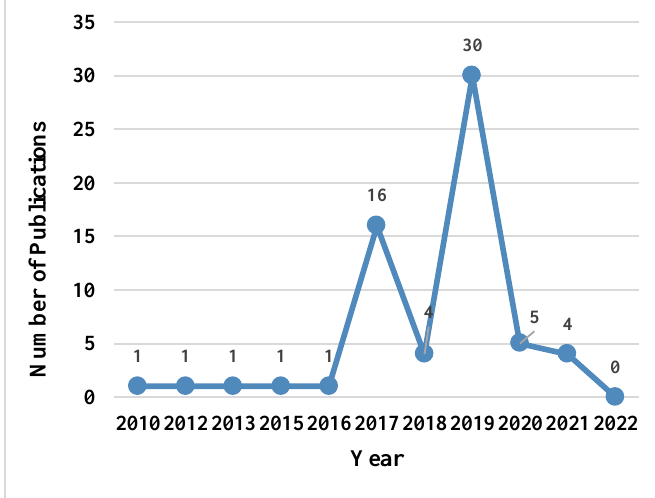
Figure 2. Distribution of retracted publications from Kazakhstan over the years The median time interval between the publication date and retraction date was 475 (46 - 2074) days.